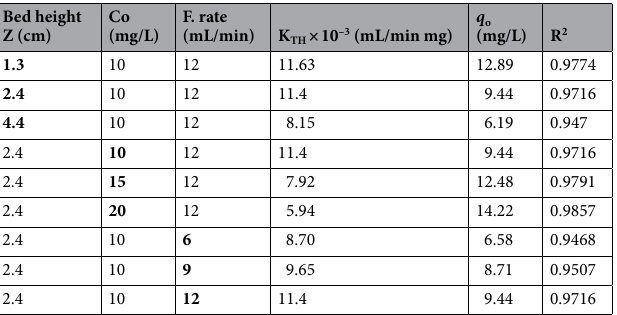
Table 6. Thomas model parameters for the adsorption of cadmium ions. Significant values are in bold.